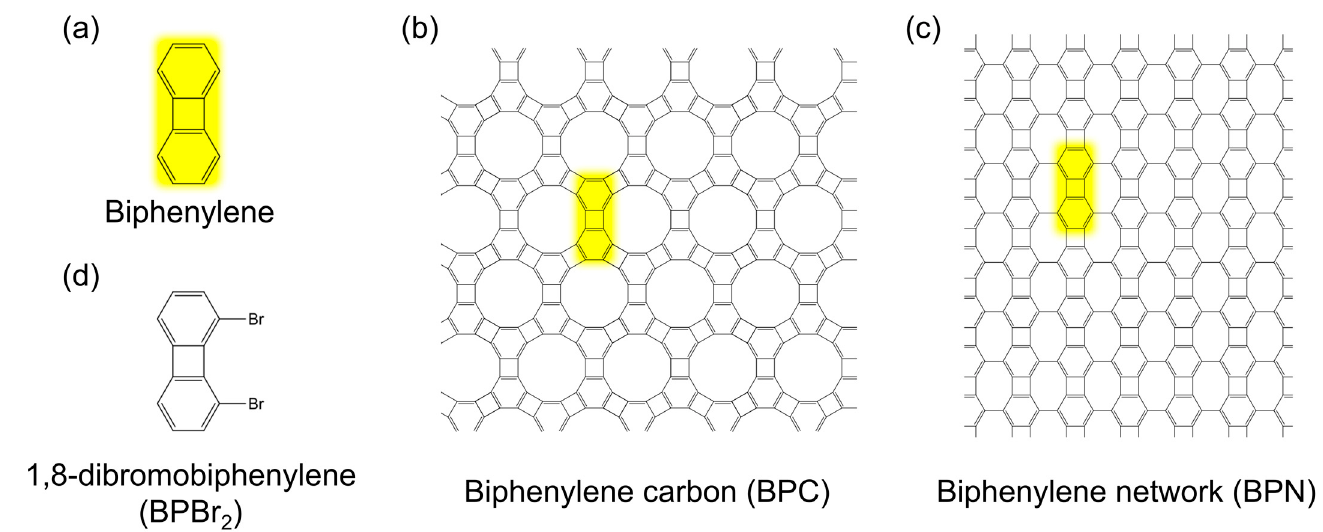
Figure 1. ( a ) Structure of biphenylene. ( b , c ) Carbon allotropes based on biphenylene: biphenylene carbon (BPC) and biphenylene network (BPN), respectively. ( d ) The structure of the molecular precursor we used, BPBr 2